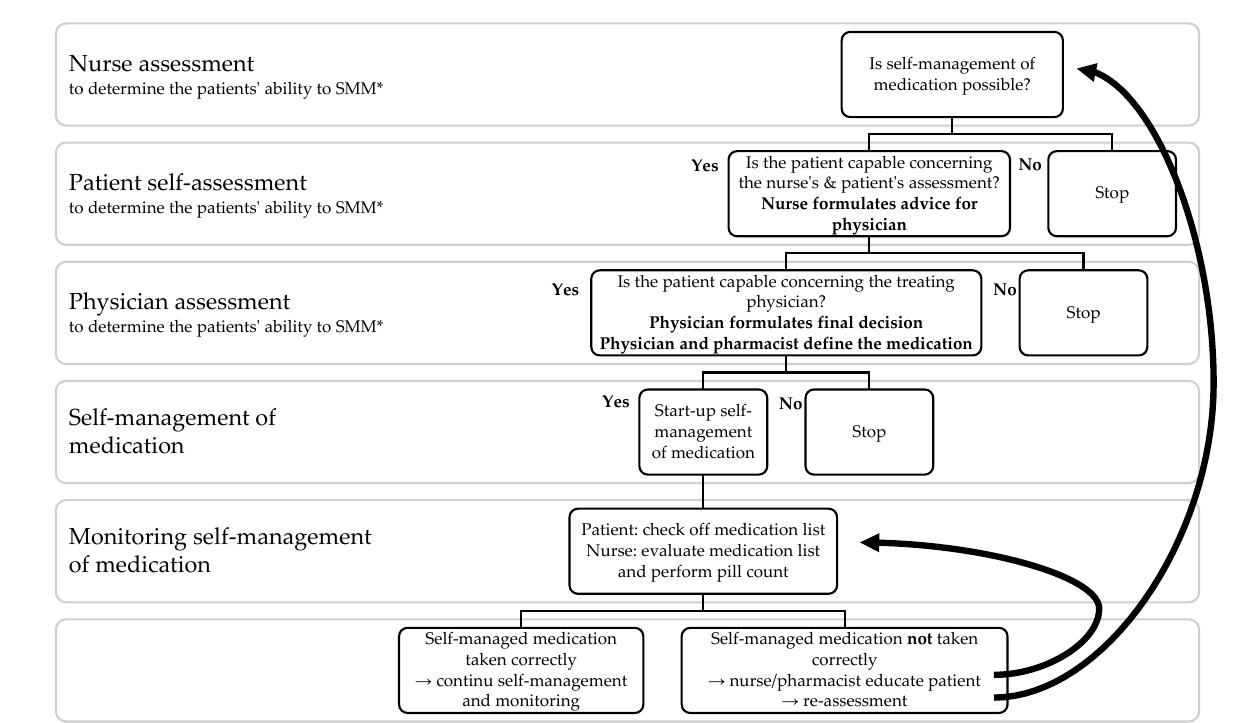
Figure 2. The SelfMED flowchart.